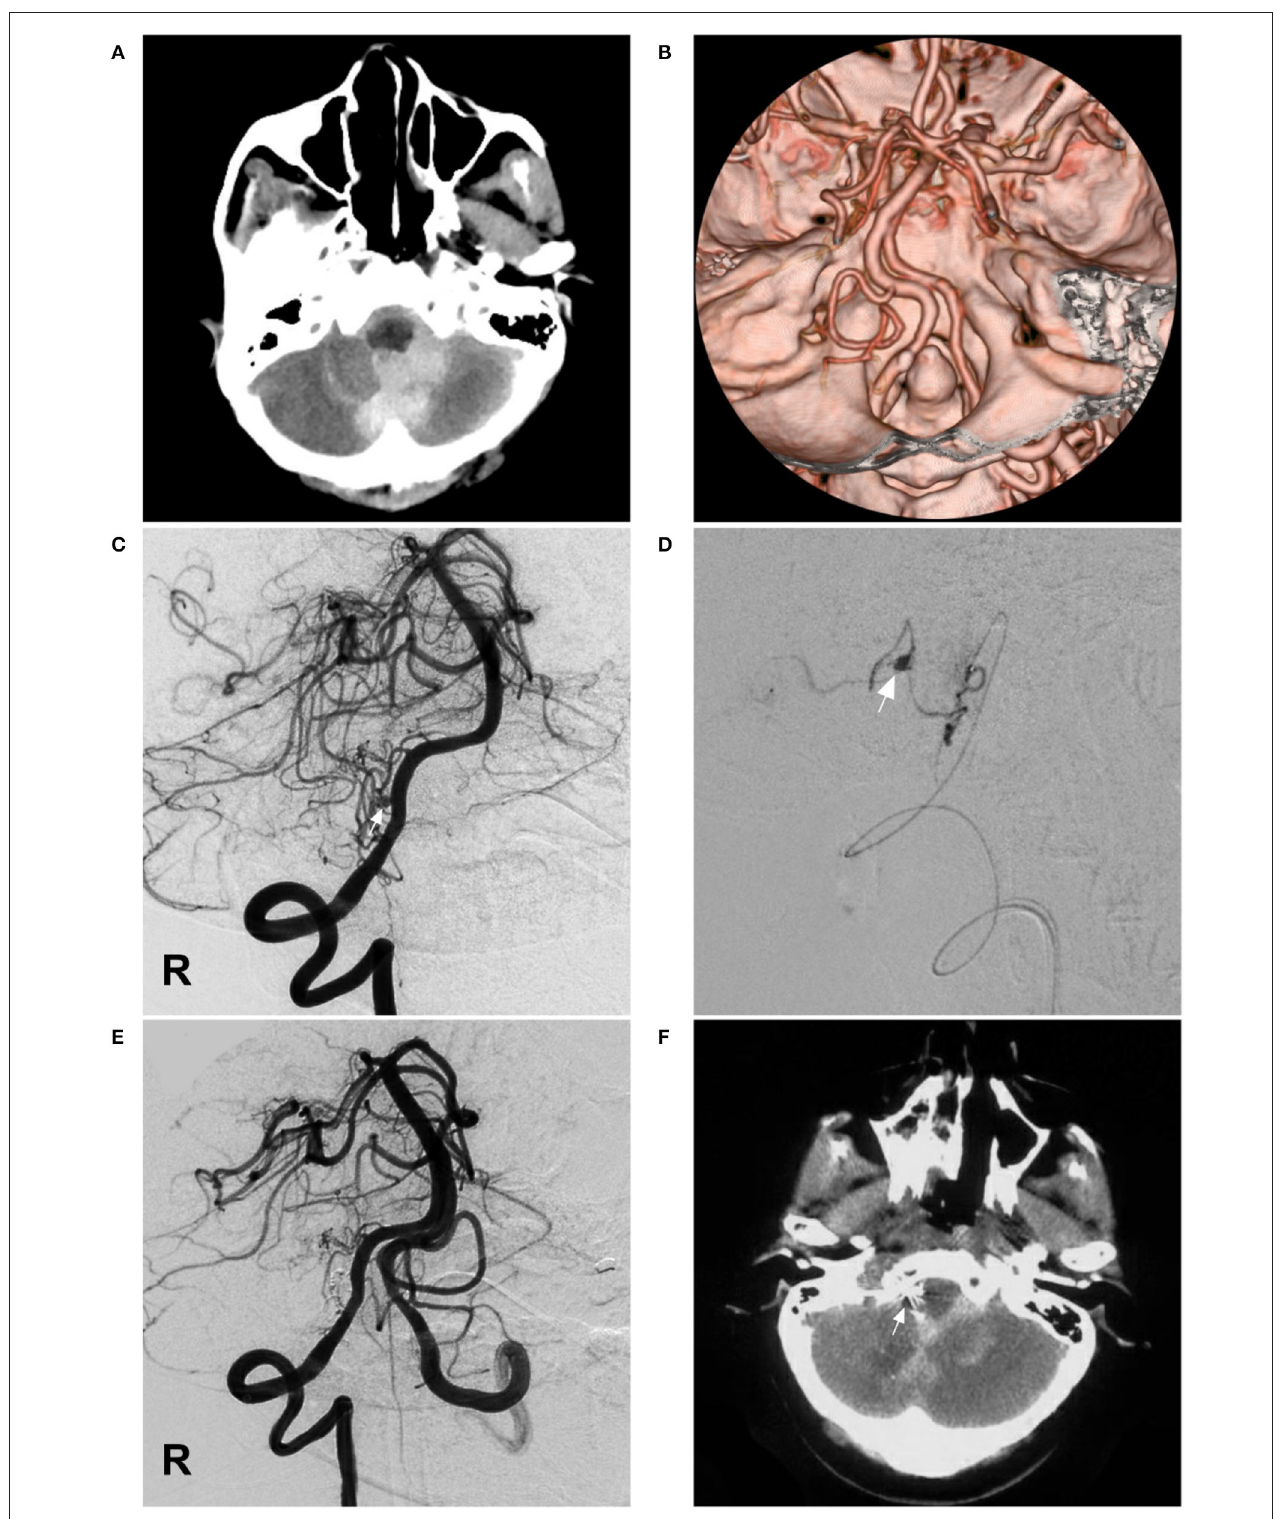
FIGURE 2 | Imaging of case 2. (A) CT shows SAH concentrated at the cisterns around the brainstem and cerebellomedullary cistern. (B) CTA reveals no vascular abnormalities. (C) Angiogram of the right VA shows a pseudoaneurysm (arrow) located in the hypoplastic and plexiform PICA. (D) Superselective angiogram of the right PICA showing the pseudoaneurysm (arrow). (E) Angiogram of the VA shows that the aneurysm and parent PICA were cast with Onyx, and other branches are visualized. (F) Postoperative CT scan shows the location of casting Onyx (arrow) and partial resolution of the SAH. CT, computed tomography; CTA, CT angiography; PICA, posterior inferior cerebellar artery; R, right; SAH, subarachnoid hemorrhage; VA, vertebral artery.